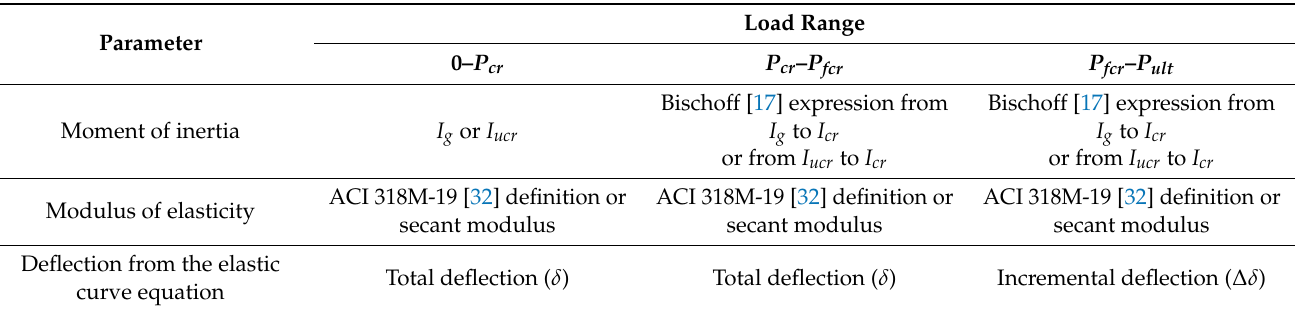
Table 5. Model A for estimating the deflections of FRP RC beams.